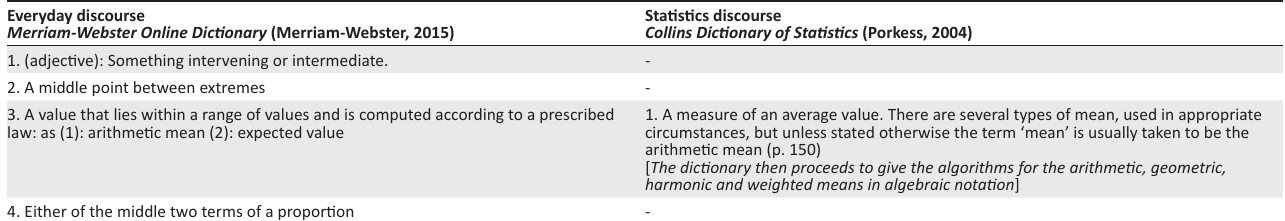
TABLE 2: Comparison of definitions of mean in everyday and Statistics